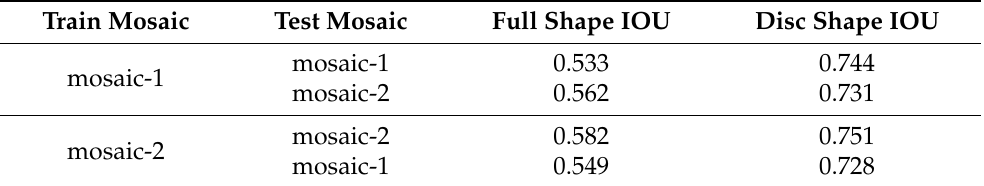
Table 3. Segmentation performance by the IOU metric for different training/testing configurations.